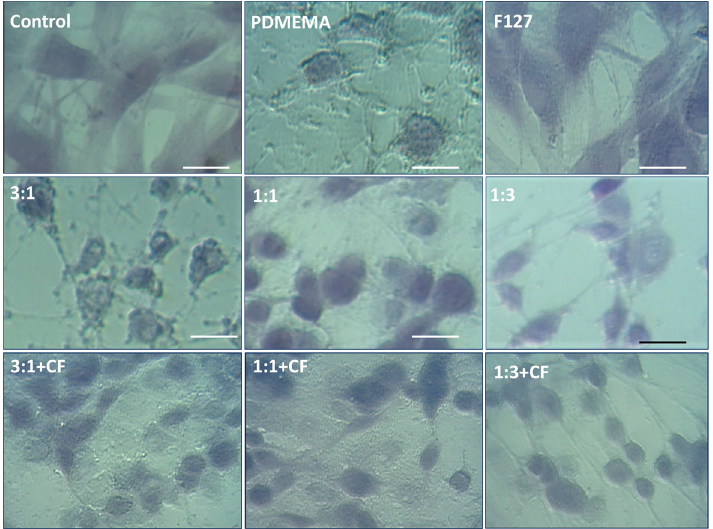
Figure 8. Morphological changes in human diploid fi broblasts (HSF) induced by SCPMs and MPMs based on PDMAEMA-b-PCL-b-PDMAEMA and Pluronic F127 triblock copolymers. Picture were taken at 200× magni fi cation.